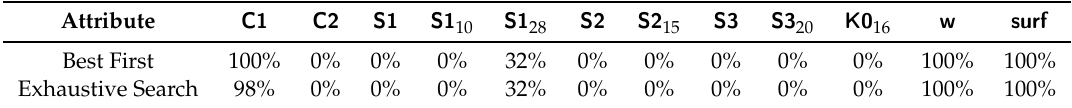
Table 5. Attribute selection cross-validation